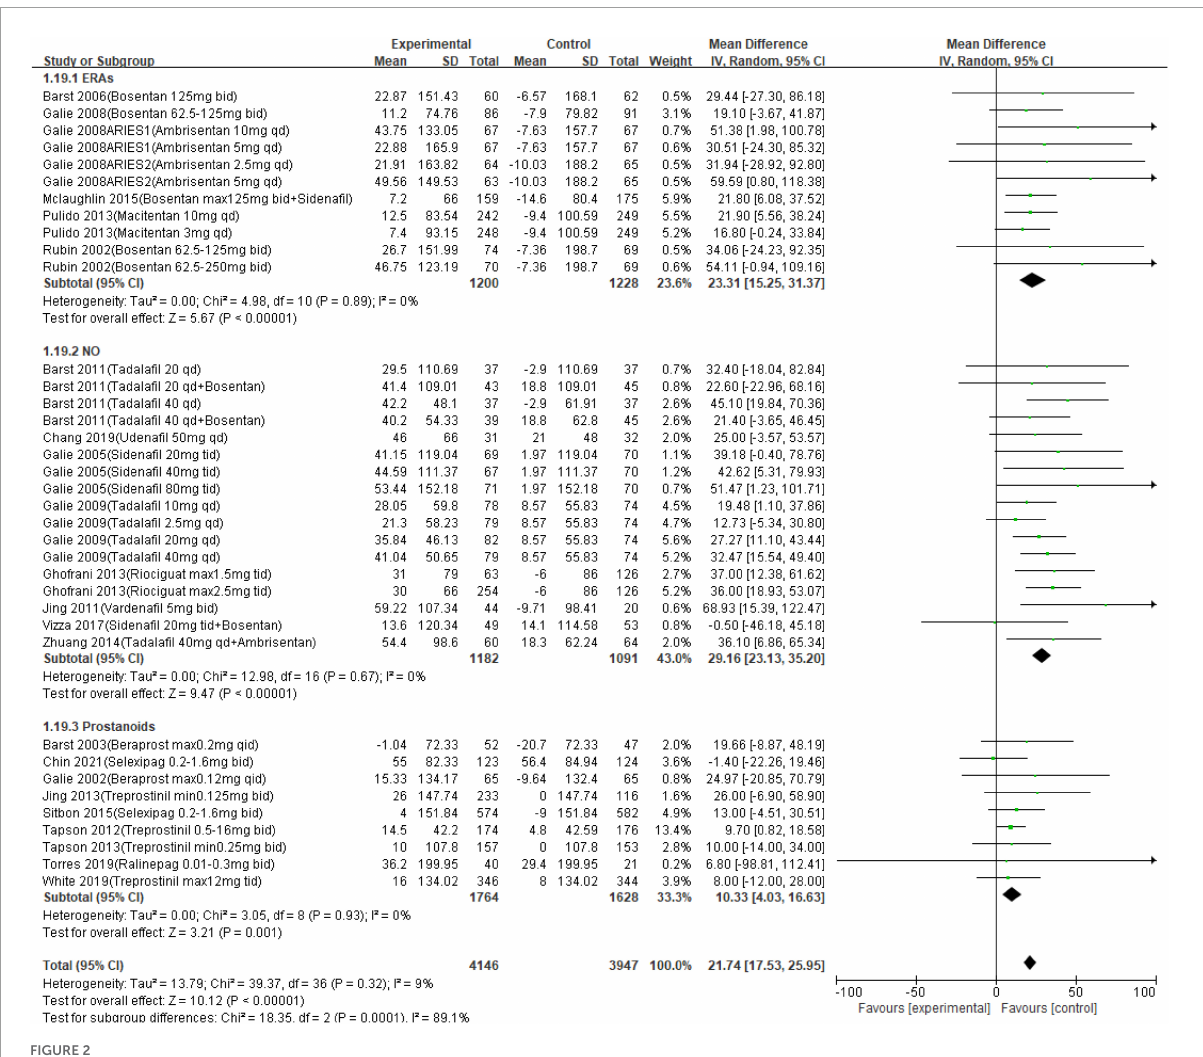
FIGURE2 Meta-analysis of 6-min walk test (6MWD) in different pathways.